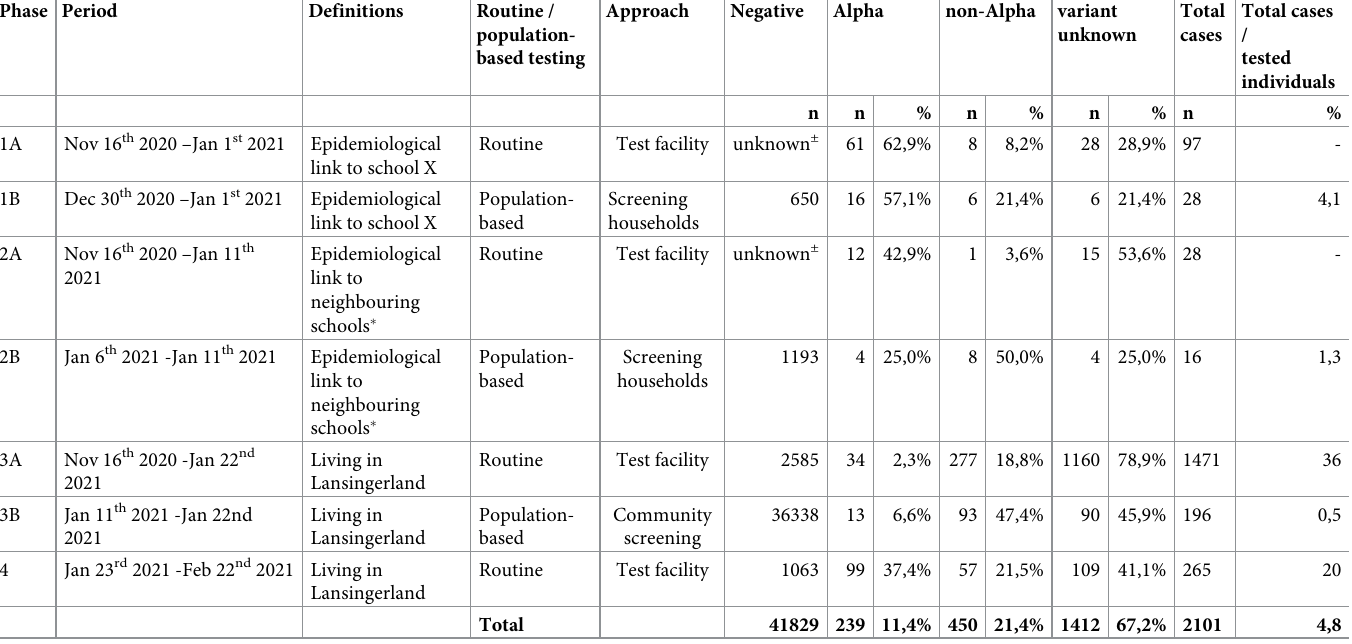
Table 1. Number of cases stratified by study phase from November 16 th 2020 to February 22 nd 2021. Phase